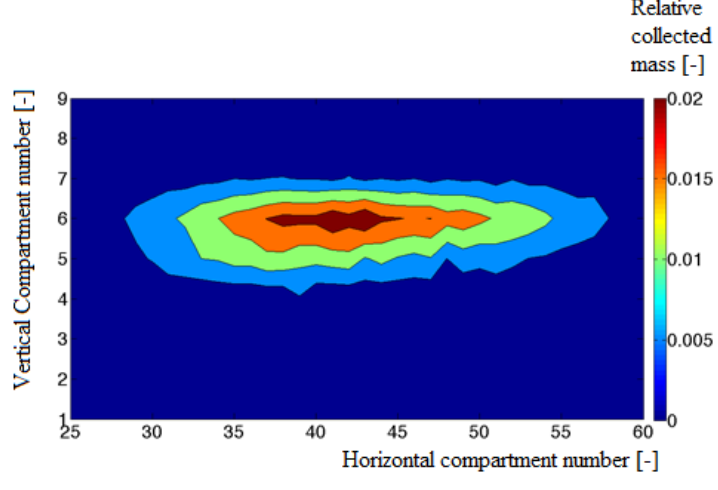
Figure 10. Cylindrical distribution simulated using the stereovision